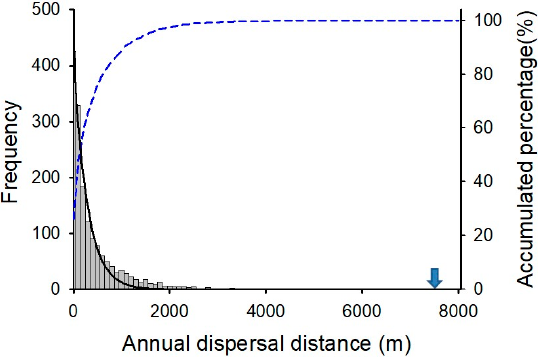
Figure 4. Frequency of annual dispersal distance with pooled data from the ten study regions and its accumulated percentage (dashed line). The solid line was fitted by the exponential decay function. An arrow indicates a maximum value (7,710 m) which is not visualized because of a low frequency value. Mean annual dispersal distances at the regional level varied by region and year. The longest and shortest mean annual dispersal distances at the regional level were 1.48 km in Geoje and 0.01 km in Miryang from 2001 to 2002. Deviations of mean annual dispersal distance between regions (0.71–0.86 km) were larger than deviations between years (0.35–0.61 km).